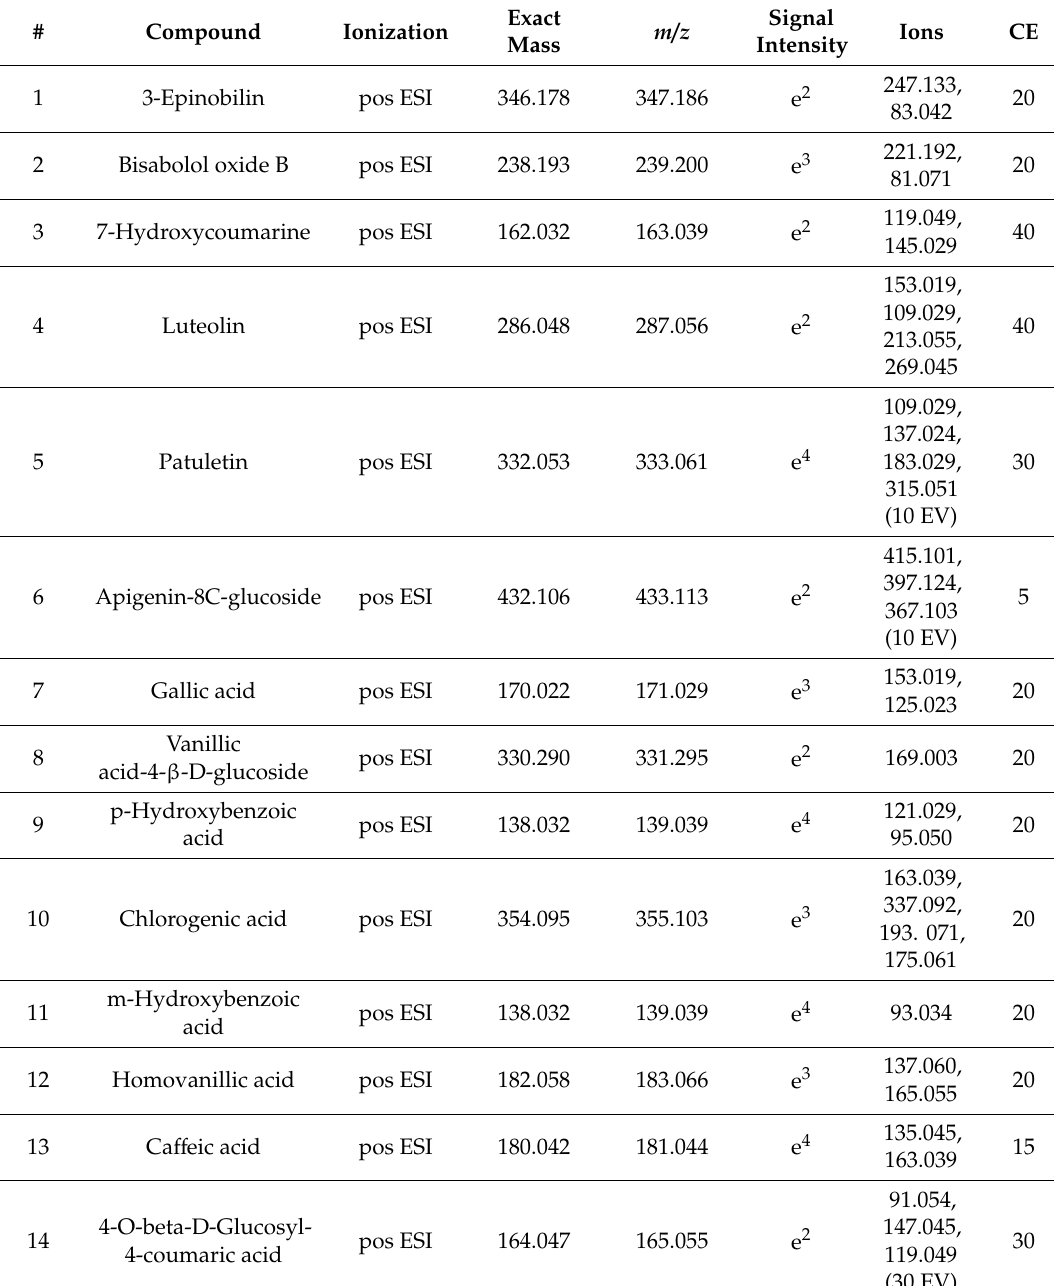
Table 2. List of polyphenols, terpenes, sesquiterpenes, fatty acids, and flavonoids present in the UD aqueous extract as detected via LCMS / MS. CE stands for collision